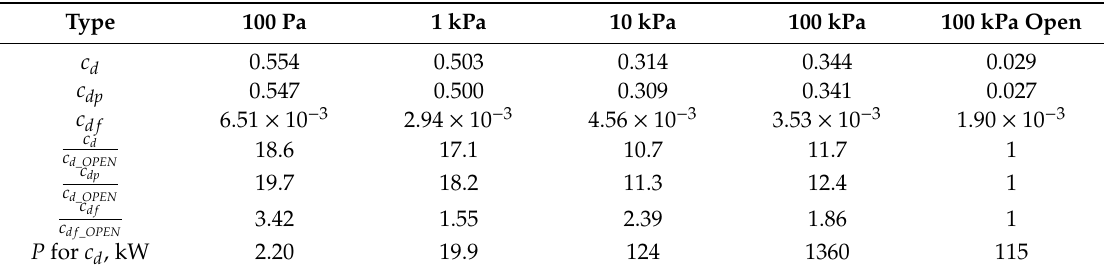
Table 1. Average values of drag coe ffi cient components and power related to the drag force. Ratio of drag acting on a moving vehicle in the tunnel to the drag in open